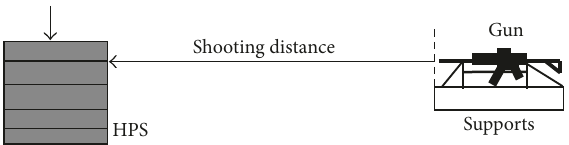
Figure 1: Experiment setup.